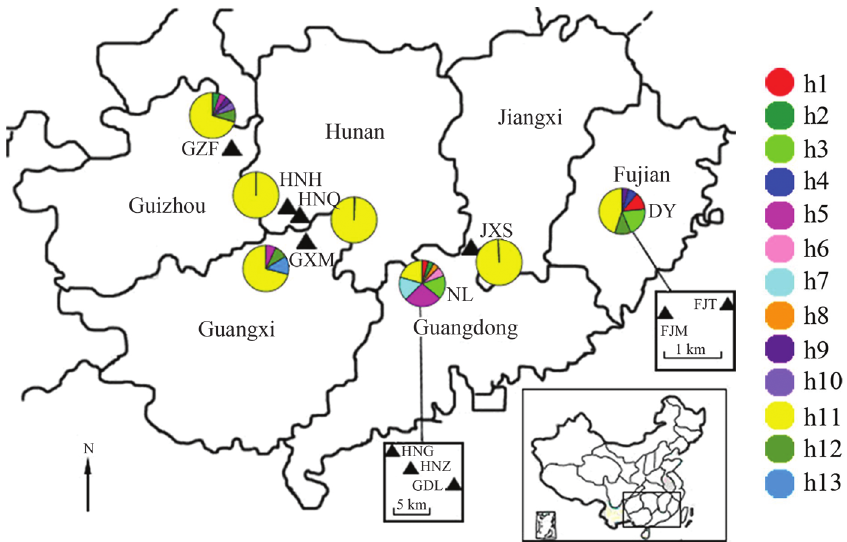
Figure 1 - Population location and geographical distribution and frequencies of cpDNA SSR haplotypes of Nothotsuga longibracteata in subtropical China